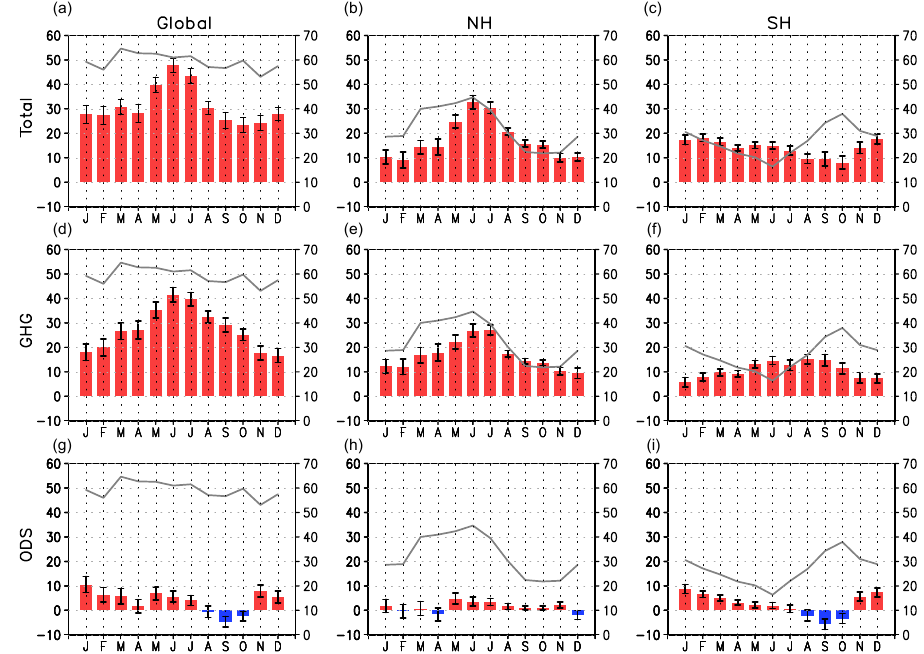
Figure 5. Annual cycle of ozone mass flux changes between 2000 and 2100 [Tgmonth − 1 ] in the time-slice simulations integrated globally (a, d, g) , over the Northern Hemisphere (b, e, h) , and over the Southern Hemisphere (c, f, i) for the changes due to all forcings (a–c) , for the effect of increasing GHG concentrations (d–f) and for the impact of declining ODS levels (g–i) . The black error bars denote ± 2 σ . The absolute ozone mass flux of the reference simulation REF2000 is shown as grey line with the corresponding y axis on the right.